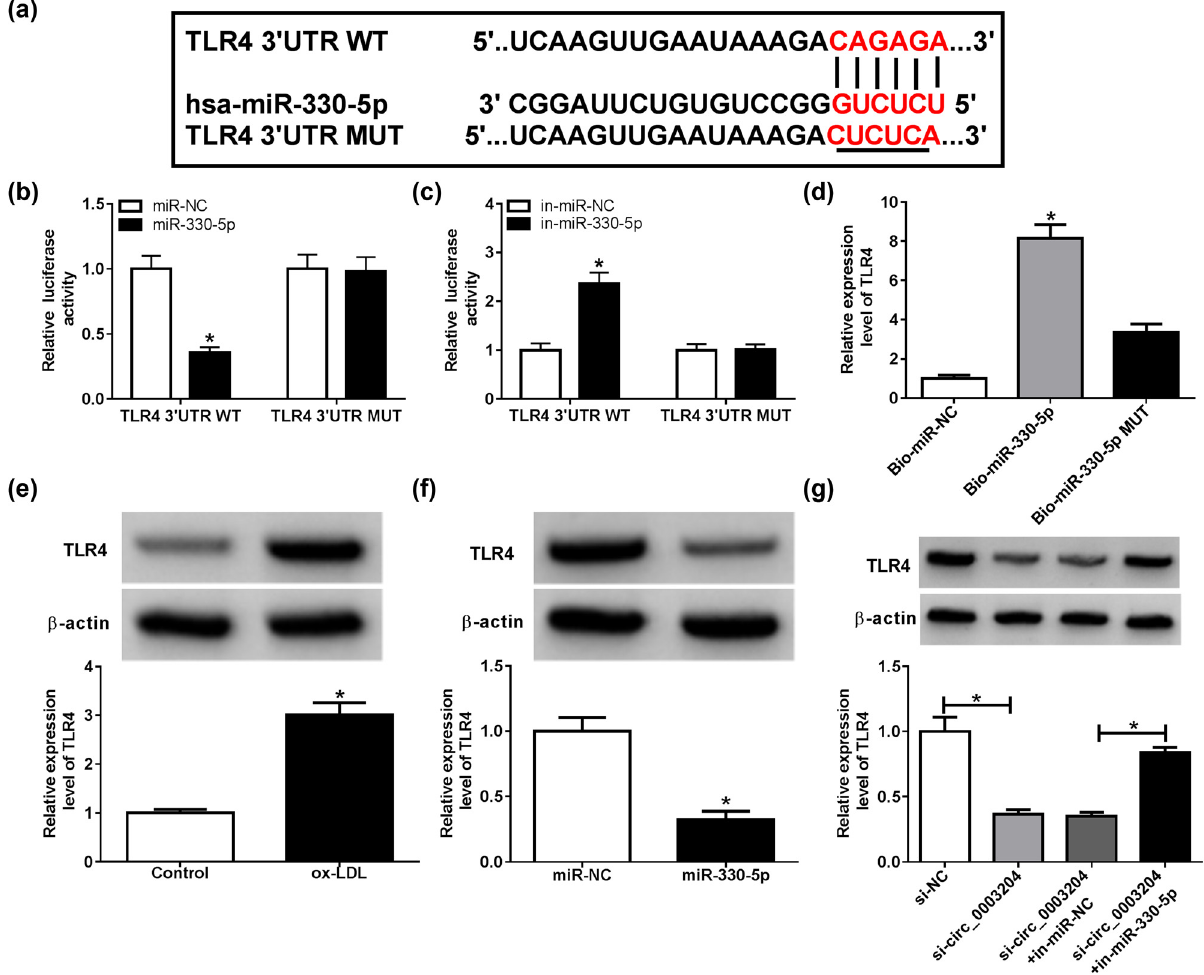
Figure 5: TLR4 was a target of miR - 330 - 5p. ( a ) The sequences of TLR4 3 ′ UTR contained the binding sites or mutant binding sites of miR - 330 - 5p were presented. ( b and c ) The luciferase activity of TLR4 3 ′ UTR WT or MUT vector in ox - LDL - induced HUVECs was measured using dual